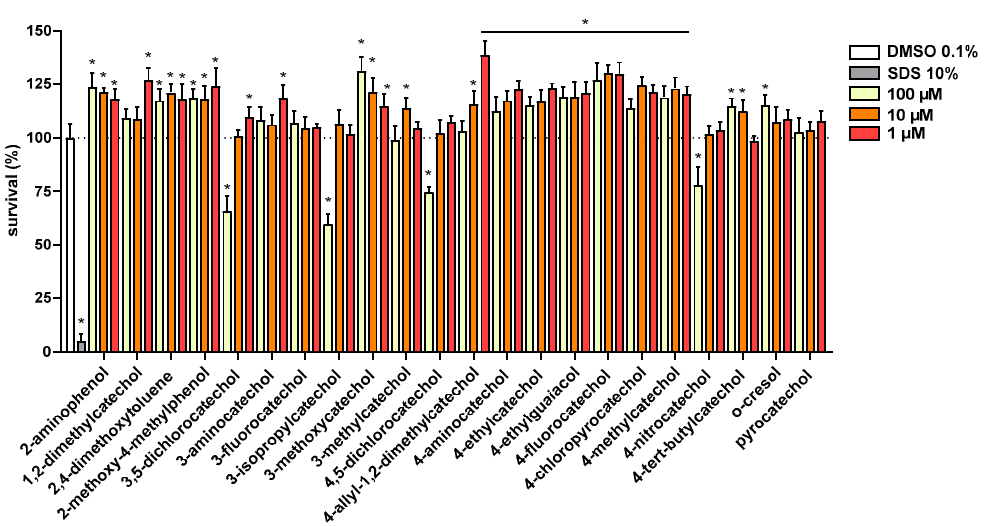
Figure 4. Cytotoxicity of All the Compounds was Tested in MCF7/S0.5 Breast Cancer Cell Line. All compounds were tested in three different concentrations and results are compared to DMSO 0.1%, set to 100% viability. SDS 10% was used as a positive control. All compounds were tested in triplicates at least three times. Statistical significance was established using a one-way ANOVA assay with confidence interval of 95% (* p < 0.001). o -Toluidin was not tested.